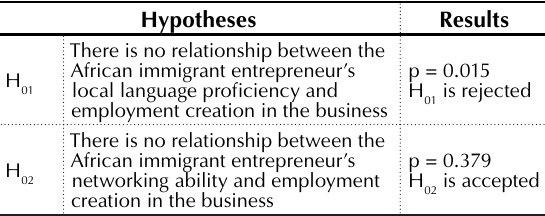
Table 6. Results of analysis of relationship